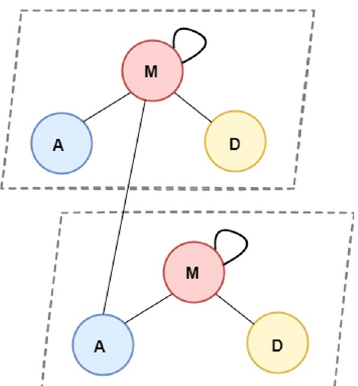
Fig. 3 Network schema graph corresponding to the multilayer heterogeneous attributed graph depicted in Fig.